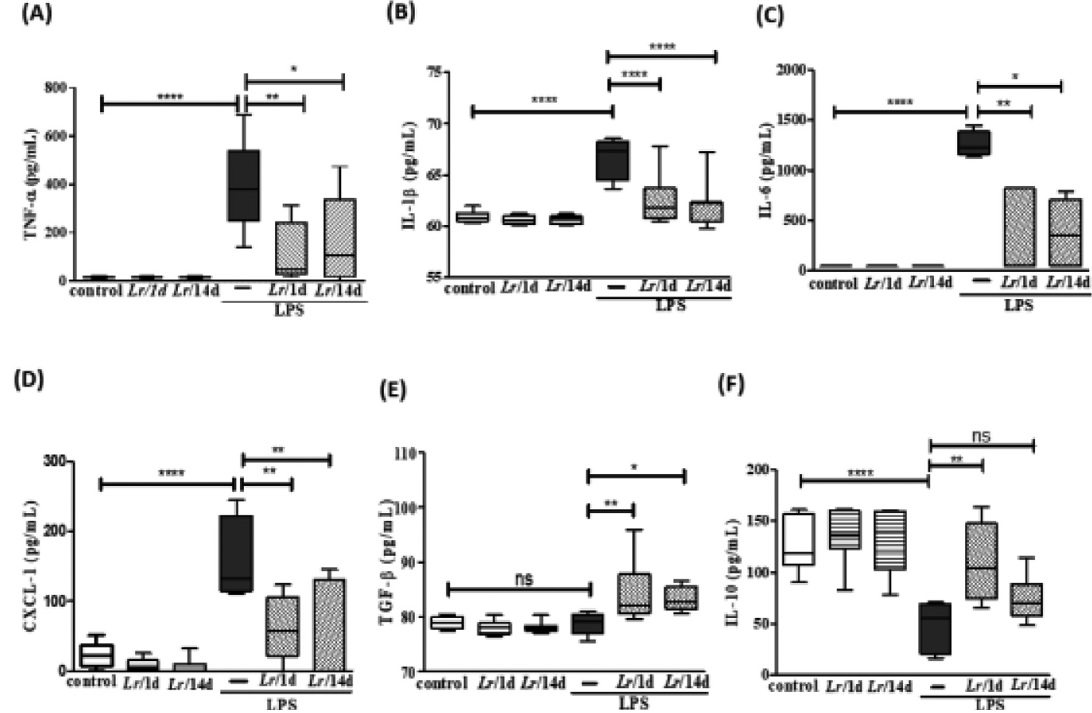
Fig. 5. Cytokines in the BALF. The C57Bl/6 mice were treated with Lacticaseibacillus rhamnosus (10 9 CFU Lr in 300 µ L of PBS, orogastric by gavage) for 14 days or one day, before E. coli LPS instillation (0.5 mg/Kg, intranasal). The mice were euthanized 24 h after the LPS, and the BALF was processed according to Materials and Meth-